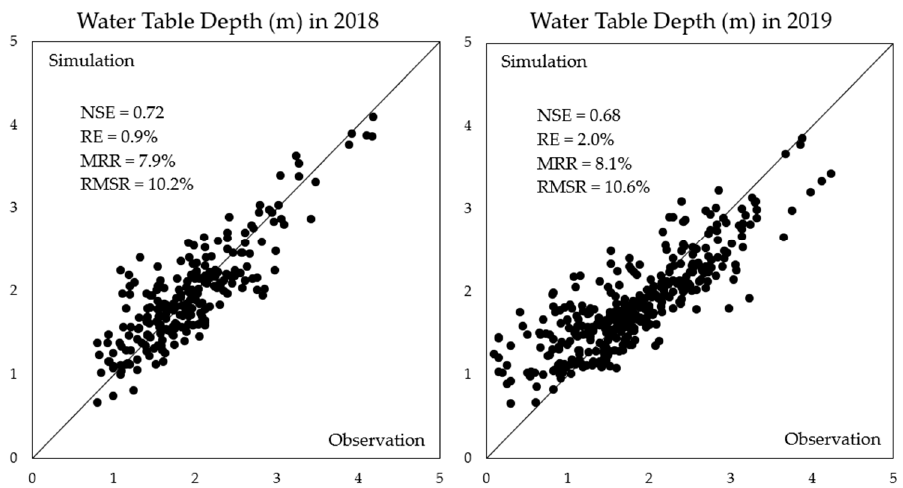
Figure 7. Comparison between simulated and observed water table depth.